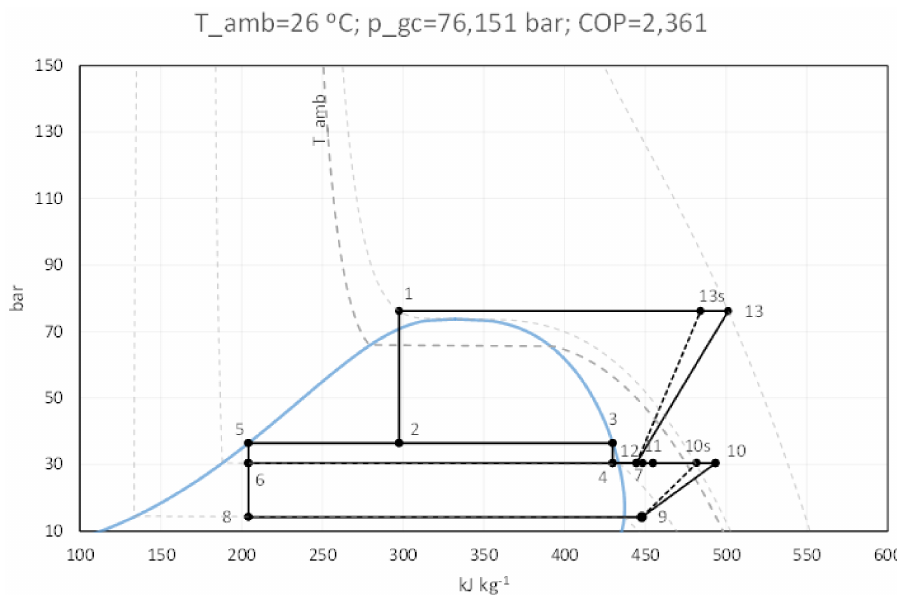
Figure 4. Transcritical CO 2 system represented in p–h diagram, for specified boundary